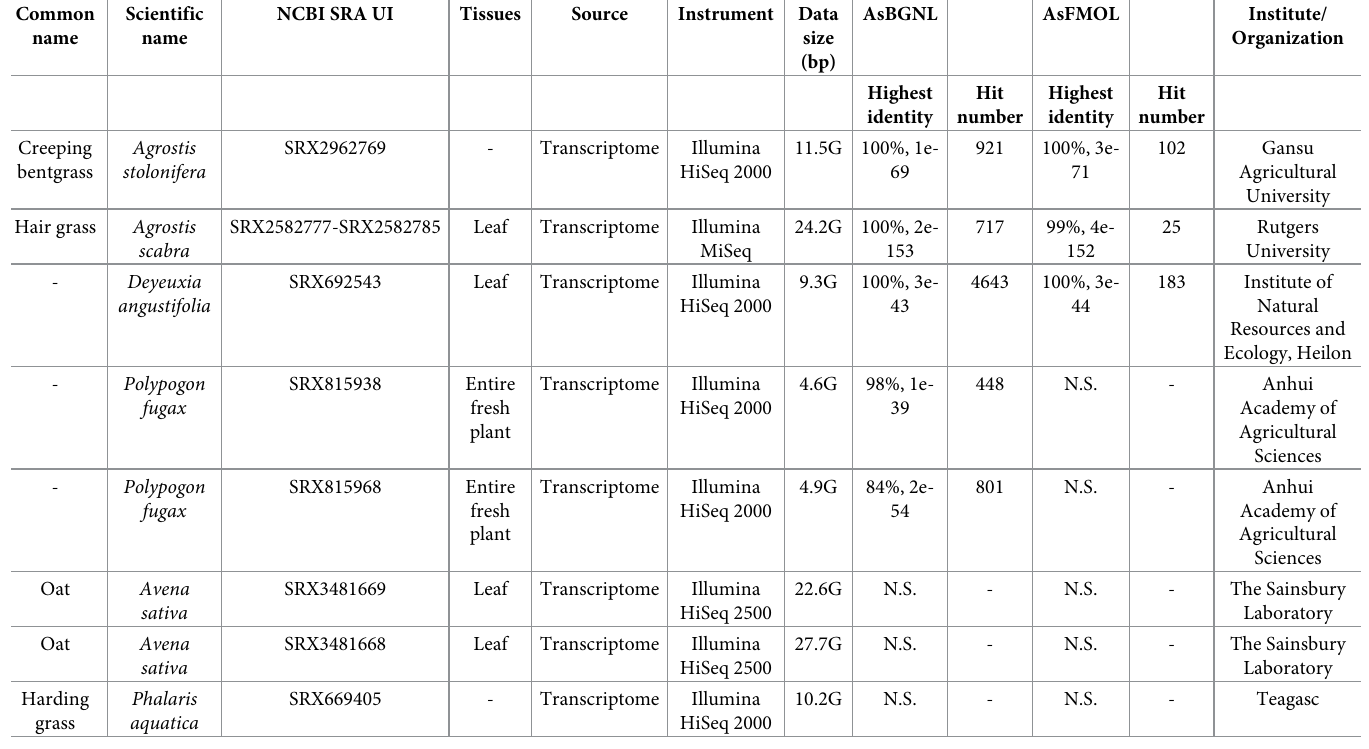
Table 1. Sequence similarity hit number and highest identity from Pooideae